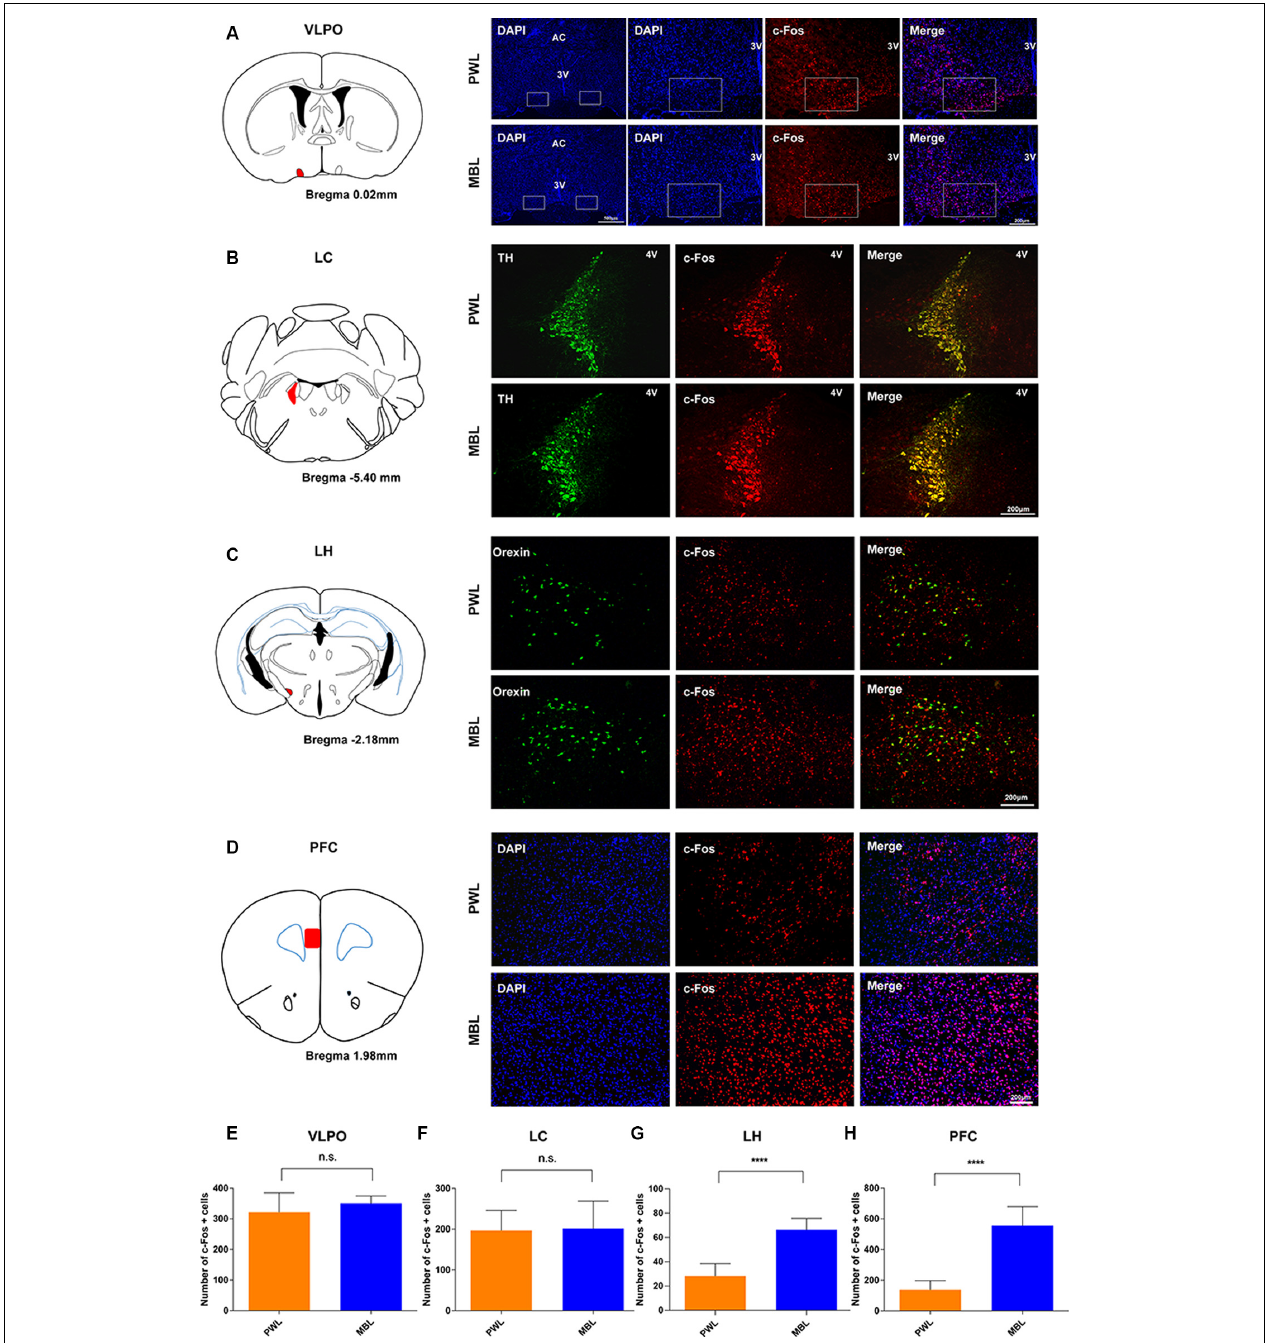
FIGURE 7 | MBL increased c-Fos expression in the LH and PFC but not in the LC and VLPO during sevoflurane anesthesia. (A–D) Effect of PWL and MBL on c-Fos expression in the VLPO (right in panel A ), LC (right in panel B ), LH (right in panel C ), and PFC (right in panel D ) during sevoflurane anesthesia. (Left in panel A ) Position of the VLPO in the mouse brain atlas. The red indicates the VLPO. (Left in panel B ) Position of the LC in the mouse brain atlas. The red indicates the LC. (Left in panel C ) Position of the LH in the mouse brain atlas. The red indicates the LH. (Left in panel D ) Position of the PFC in the mouse brain atlas. The red indicates the PFC. 3V, third ventricle. 4V, fourth ventricle. AC, anterior commissure. Scale bar = 200 µ m. (E–H) Quantitative analysis of the number of c-Fos-positive cells in the PWL and MBL groups. The MBL group showed an increase in c-Fos expression compared to the PWL group in areas of the LH and PFC (**** p < 0.0001 compared with PWL, n = 6–8 in each group, and unpaired Student’s t -tests with Welch’s correction). The MBL-treated animals showed no statistically significant difference in VLPO and LC c-Fos expression compared to the PWL-treated animals. Data are expressed as mean ± SD (n.s. = not significant, compared with PWL, n = 6–8 in each group, and unpaired Student’s t -tests with Welch’s correction). VLPO, ventrolateral preoptic area. LC, locus coeruleus. LH, lateral hypothalamus. PFC, the prefrontal cortex. PWL, polychromatic white light; MBL, monochromatic blue light.